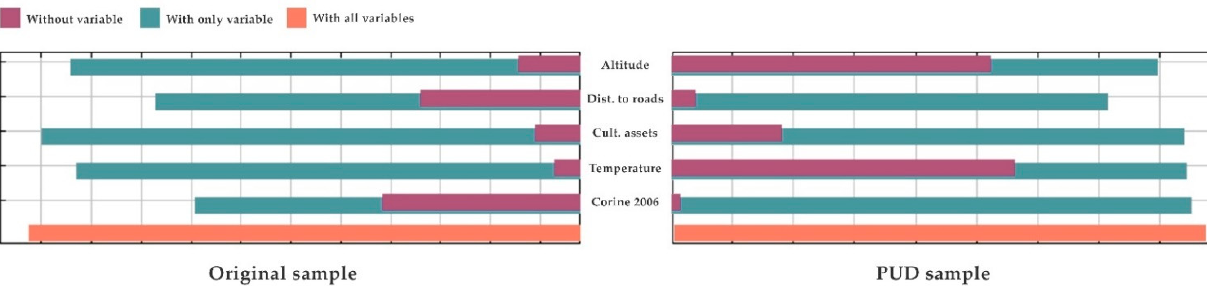
Figure 7. Jackknife test applied to environmental values for each of the samples.